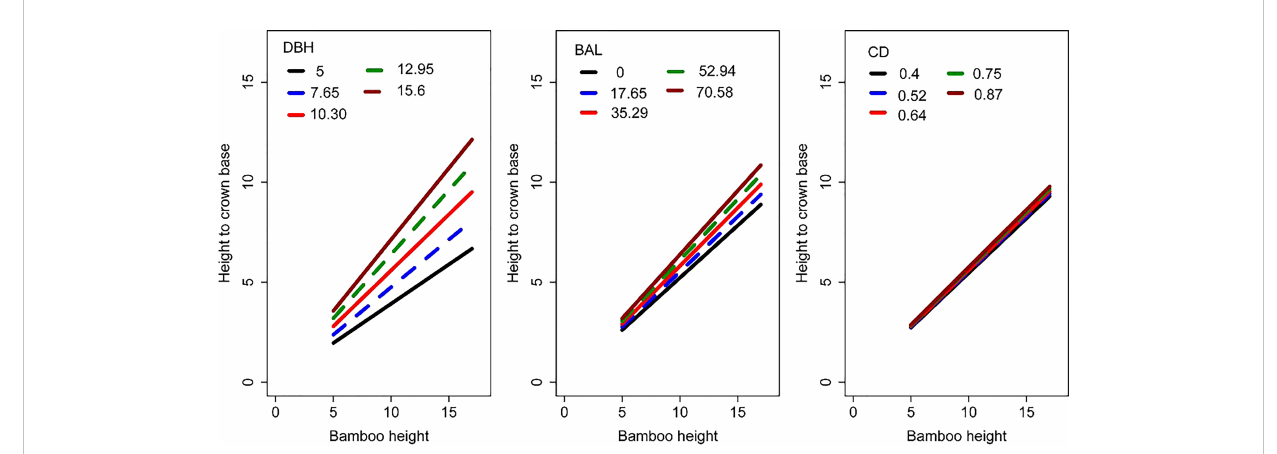
FIGURE 4 Simulation of the impact of DBH, BAL, and CD on HCB. The HCB model used for this simulation is Eq. 11.